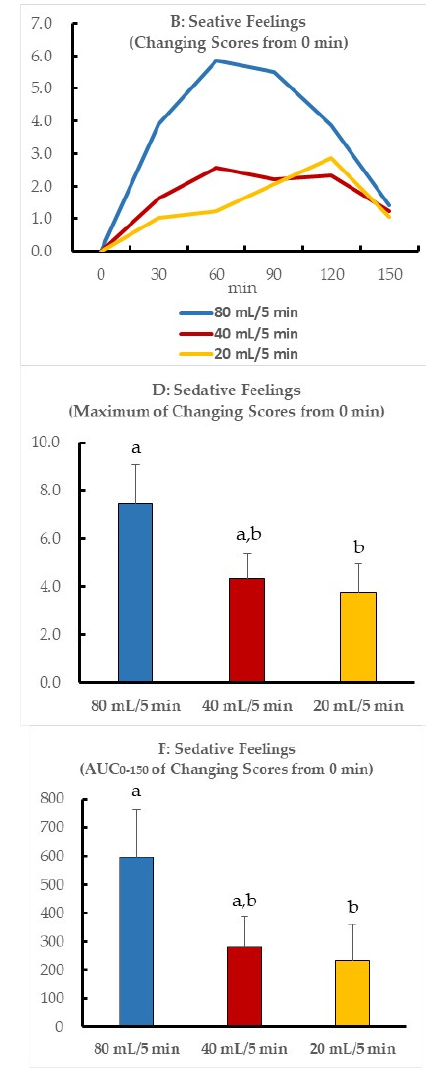
Figure 2. ( A ) Temporal changes in the mean sum of the three scores of the stimulation subscale (Energized, Excited, and Up) are indicated as mean values. ( B ) Temporal changes in the mean sum of the three scores of the sedation subscale (Sedated, Slow thoughts, and Sluggish) are indicated as mean values. The scores of the subjective stimulant or sedative feelings reported by the volunteers after beer ingestion are expressed as means and standard deviation (( C ) maximal scores of stimulant feelings, ( D ) maximal scores of sedative feelings, ( E ) AUC 0–150 of temporal scores of stimulant feelings, ( F ) AUC 0–150 of temporal scores of sedative feelings). Scores with different letters (a,b) are significantly different among the three drinking speeds at p < 0.05 according to the Bonferroni test.